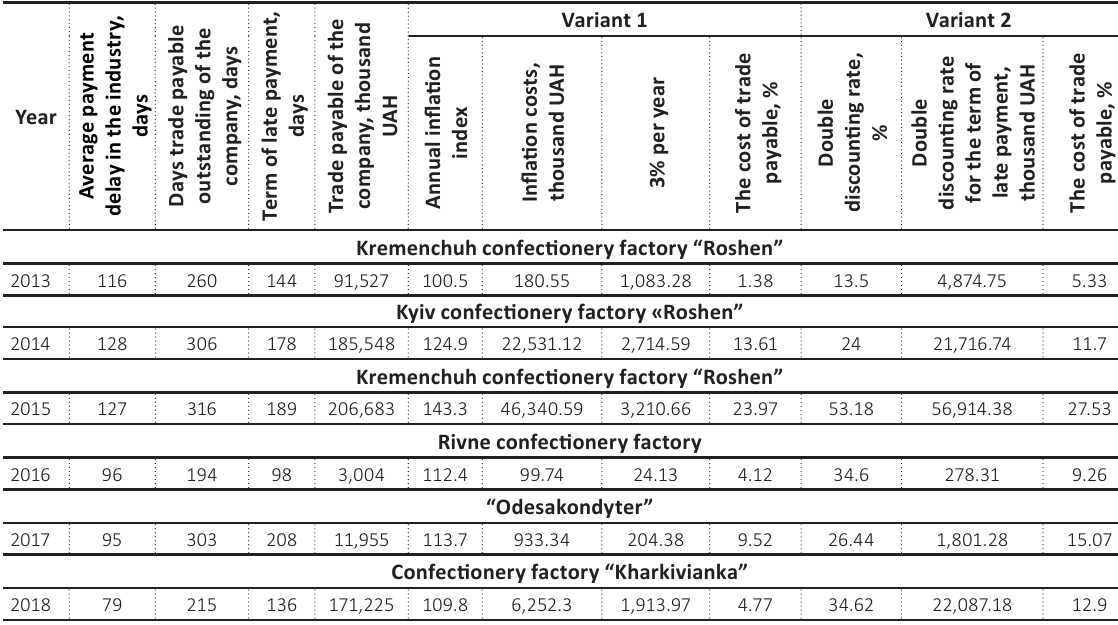
Source: Calculated by the